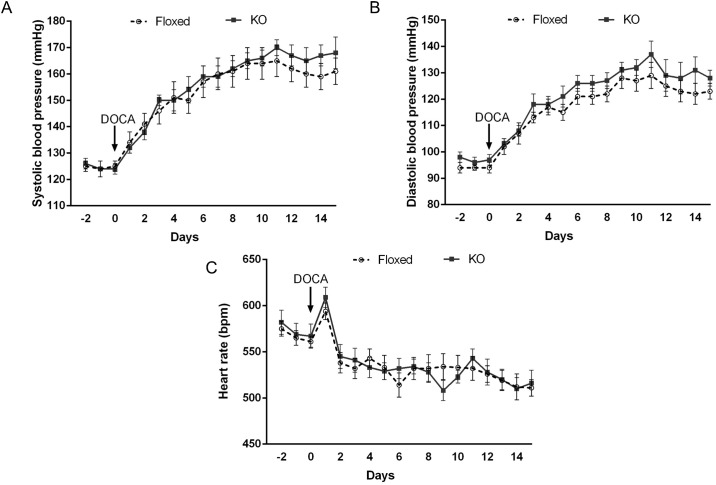
Effect of DOCA-salt treatment on systolic (A) and diastolic (B) blood pressure, and heart rate (C) measured by telemetry in floxed and CD renin KO mice, N = 9–10 for each group.